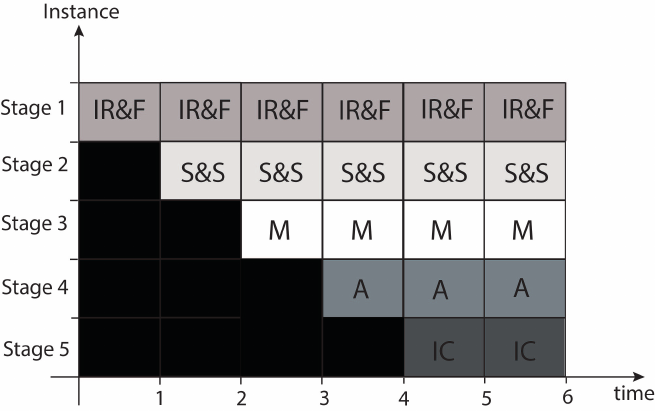
Figure 12. Temporal diagram of the 5-stage pipeline for the AES